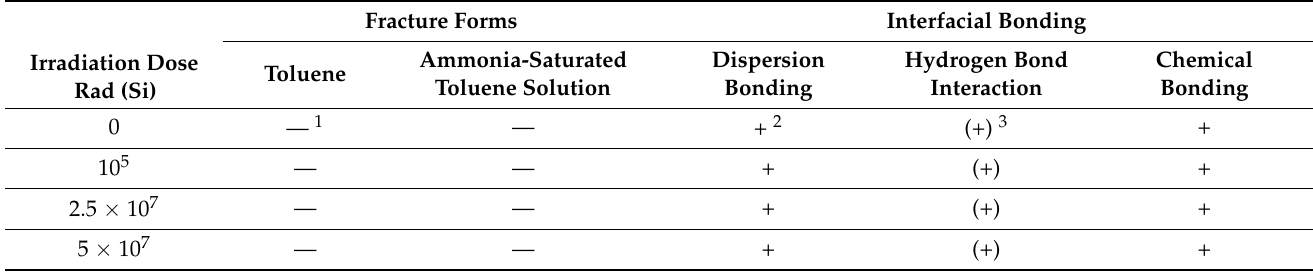
Table 4. Analysis of solution erosion and interface adhesion at silicone encapsulant/FR-4 bonding interface.